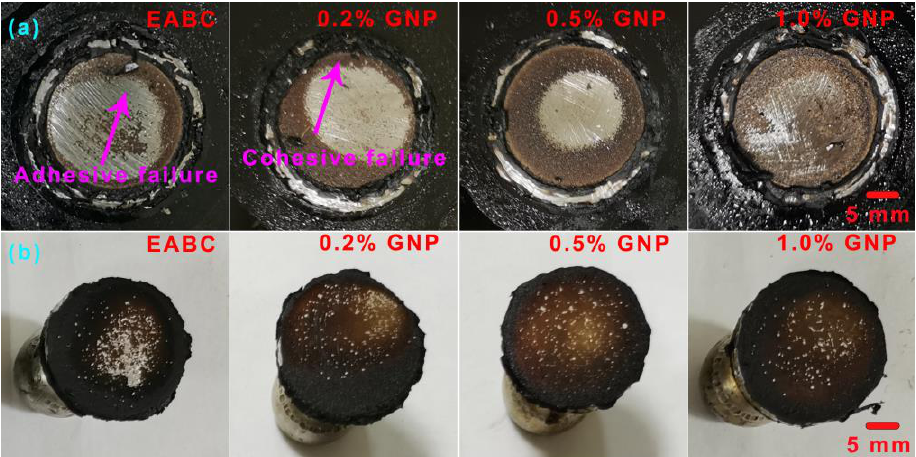
Figure 17. Surfaces of steel plates ( a ) and dollies ( b ) bonded with GNP-reinforced EABCs after room-temperature pull-off adhesion tests.